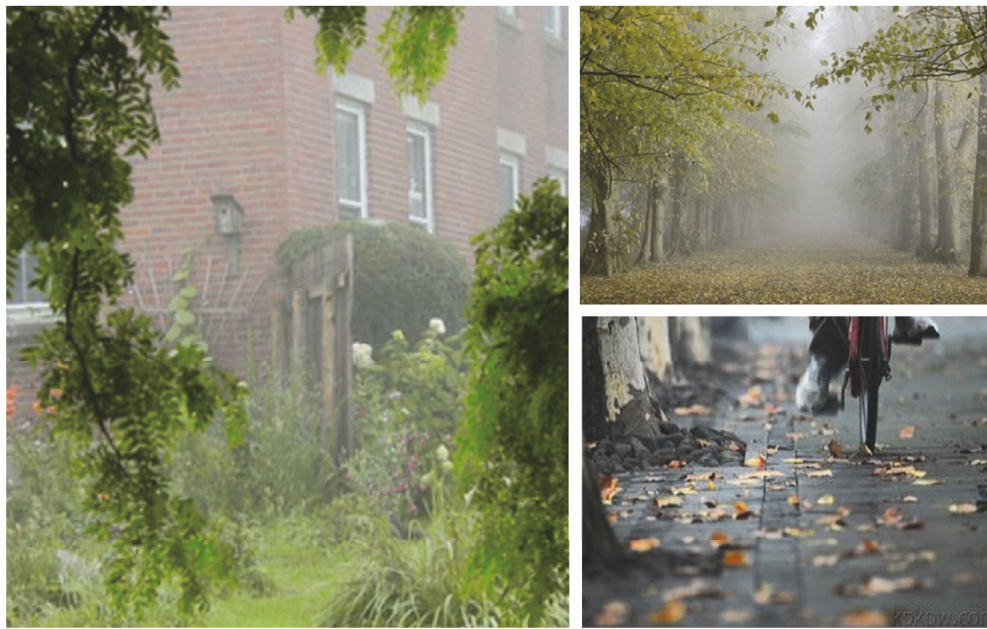
Figure 1: Original images without obvious light color